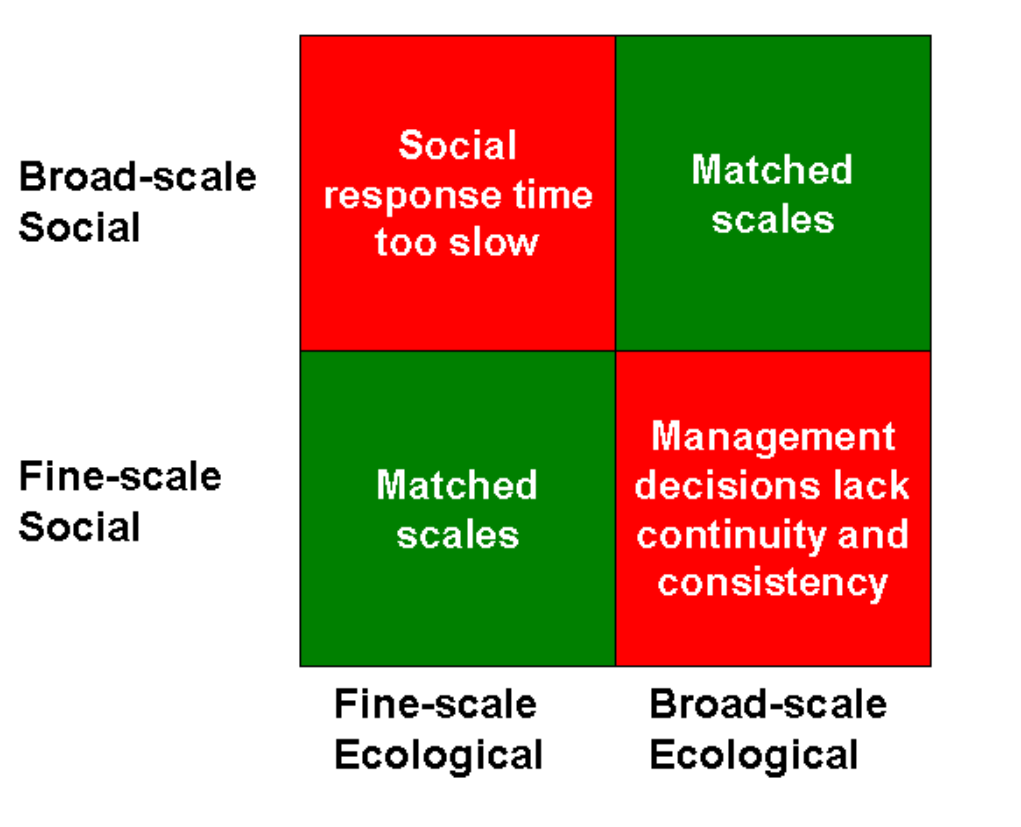
Fig. 2 . Consequences of mismatched temporal scales (indicated in red) between social and ecological systems. For example, some ecological problems, such as the management of long-lived and slowly reproducing species like redwood trees, baobabs, whales, and elephants, require consistent, long-term policies that may be difficult to achieve over time horizons of 50 yr in western democracies. In contrast, it may take time for large bureaucracies and cumbersome organizations to face up to and deal with rapid ecological changes that demand immediate management action, such as the sudden introduction of an invasive